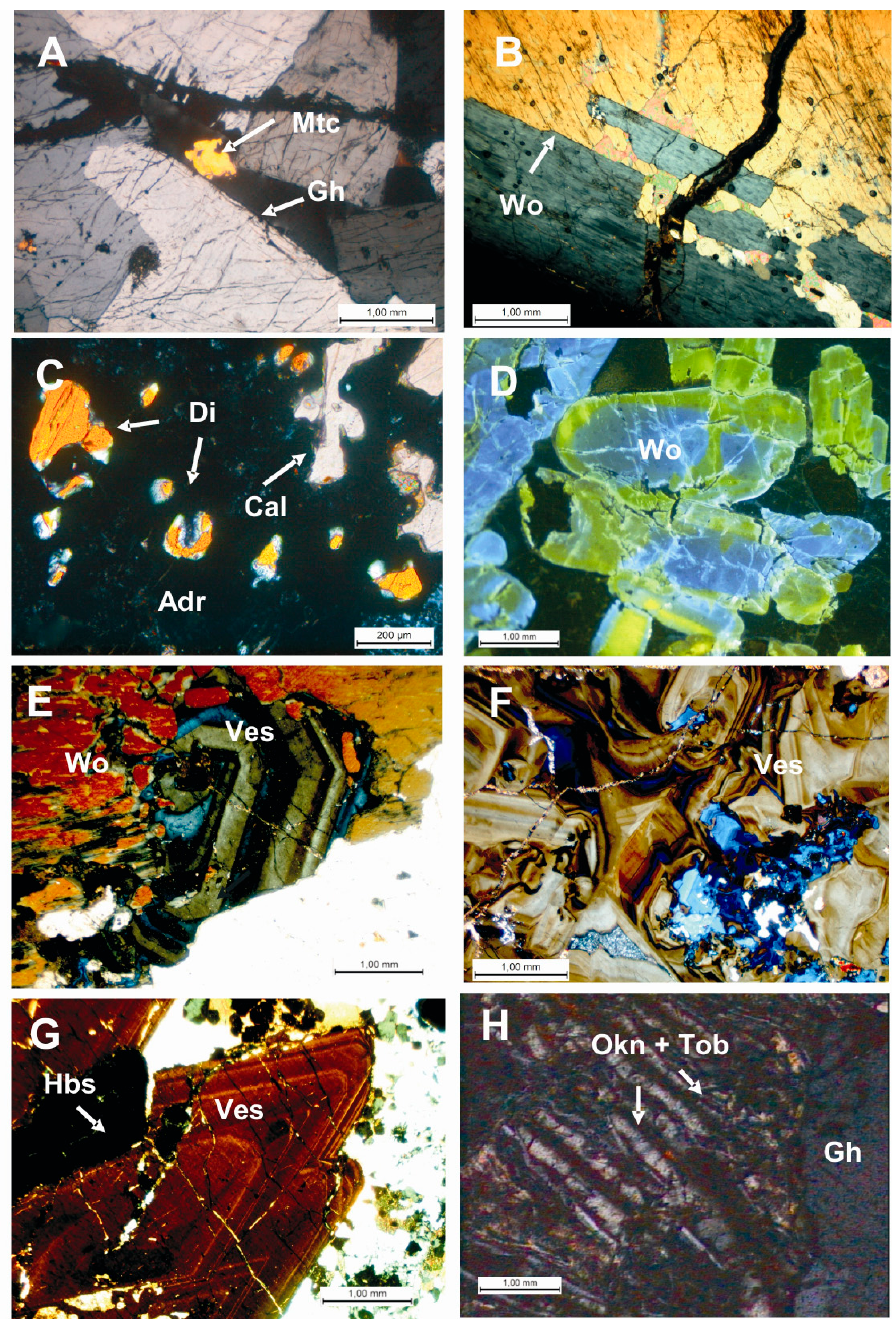
Figure 4. Photomicrographs showing characteristic relationships between minerals in the M ă gureaua Va ţ ei skarn. ( A ) Crystal of monticellite (Mtc) engulfed by gehlenite (Gh). Sample Cer-G-5-069, B zone, crossed polars.); ( B ) Mass of wollastonite-2 M (Wo). Sample CE005-c, C zone, crossed polars; ( C ) Crystals of diopside (Di) and pads of calcite (Cal) in the Ti-andradite (Adr) mass. Sample Cer-G-5-018, A 1 zone, crossed polars; ( D ) Cathodoluminescence photomicrograph showing zoning in wollastonite (Wo) crystals. Sample 2292, C zone; ( E ) Zoned vesuvianite (Ves) in the wollastonite (Wo) mass. Sample CE0058-f, B zone, crossed polars; ( F ) Zoned and brecciate vesuvianite (Ves). Sample Cer-W-6-002. BV zone, crossed polars; ( G ) “Hibschite” (Hbs) on the fractures of optically zoned vesuvianite (Ves) crystals. Sample 2161, B zone, crossed polars. ( H ) Aggregates of okenite (Okn) and tobermorite (Tob) on a fissure a ff ecting the gehlenite (Gh) mass. Sample CE 4 b, B zone, crossed polars. When possible, symbols of the rock-forming minerals after